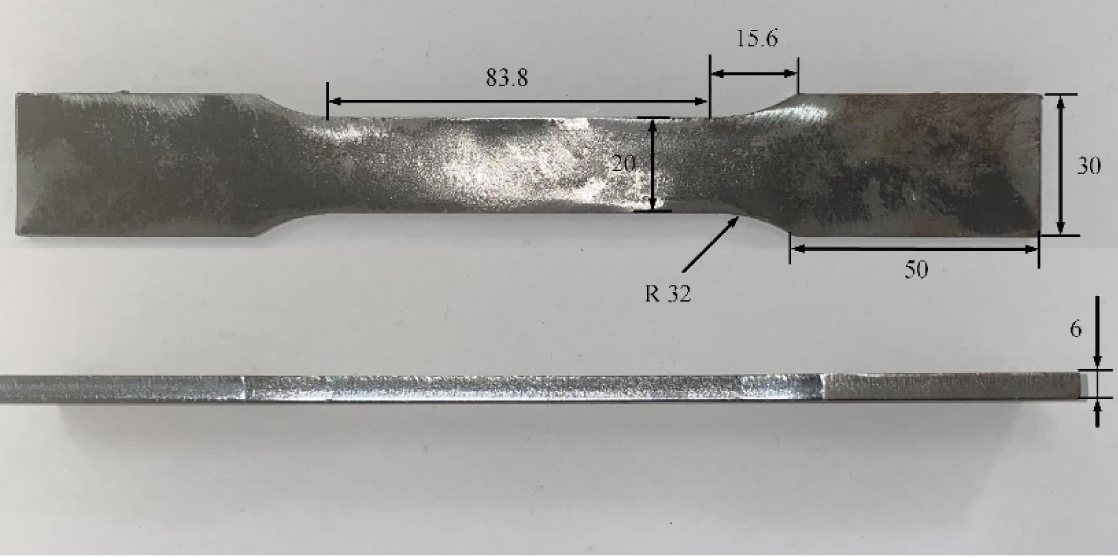
Figure 4. The static tensile